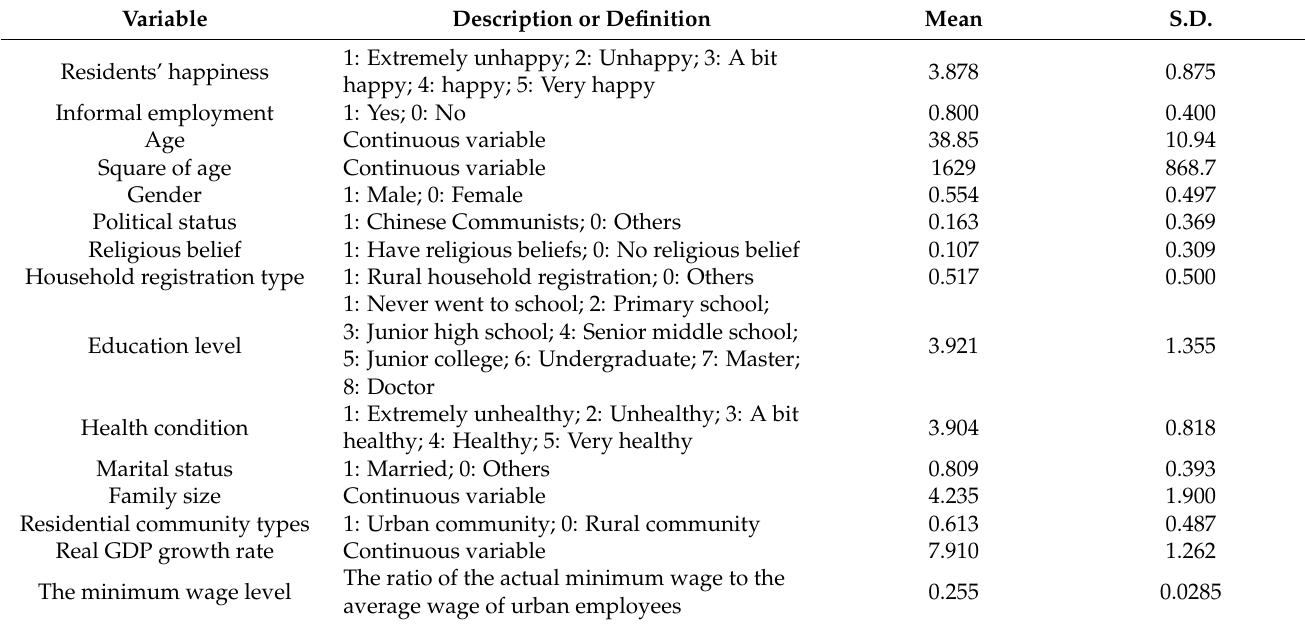
Table 1. Variable definitions and descriptive statistical